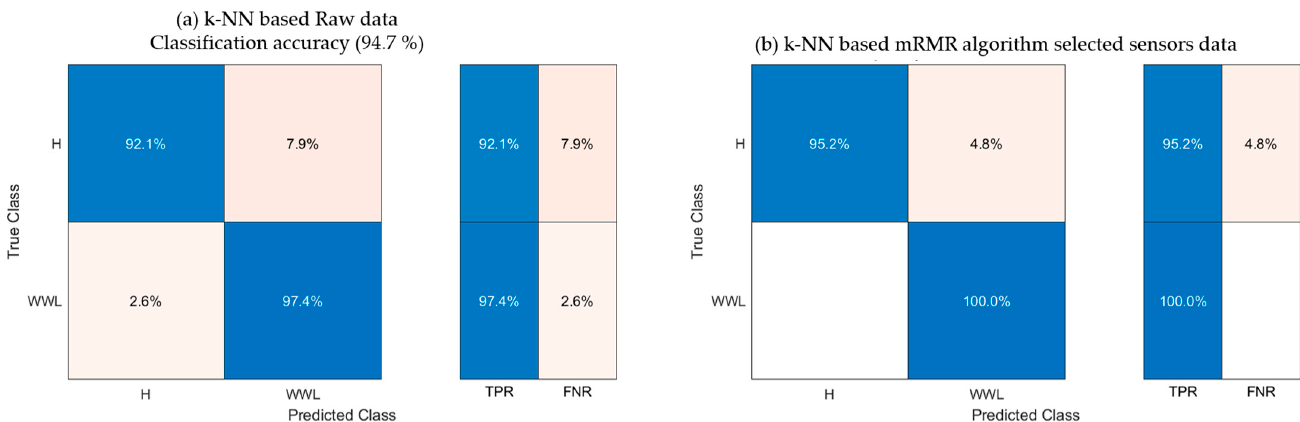
Figure 12. ( a ) Confusion matrix for the k-NN-based raw data case scenario; ( b ) confusion matrix for the k-NN-based mRMR algorithm case scenario.